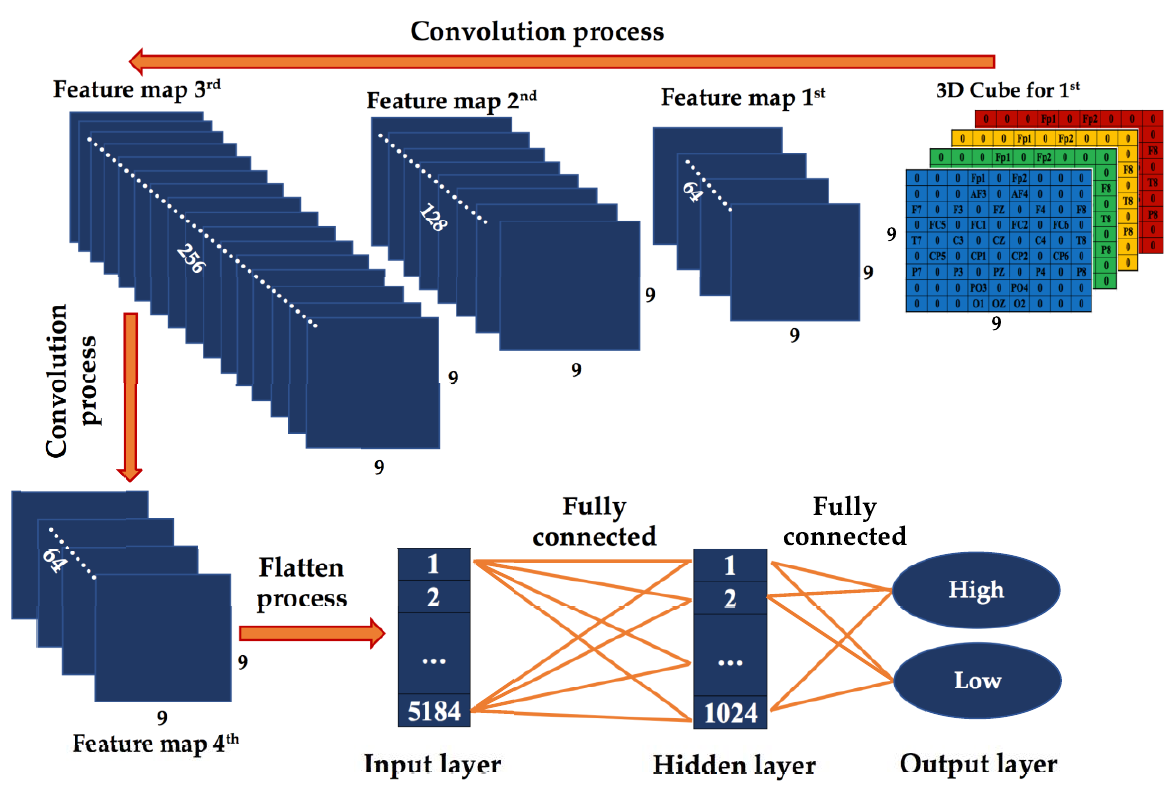
Figure 1. The architecture of the CNN method for four emotion classes